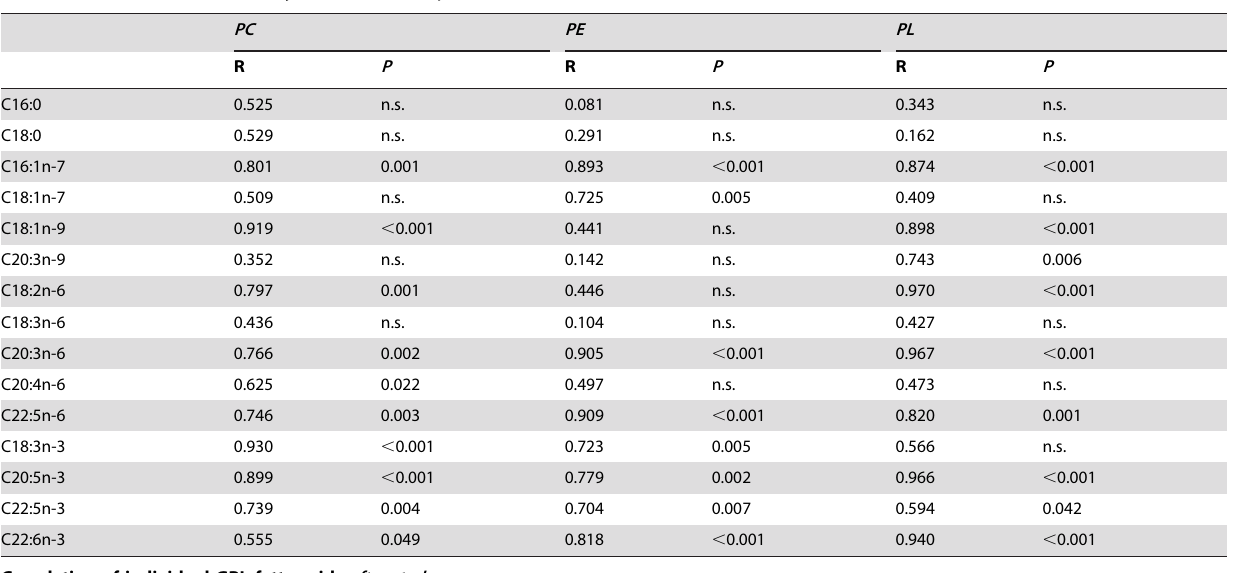
Table 4. Correlations between RBC GPL fatty acids and other RBC PL fractions before and after n-3 supplementation.